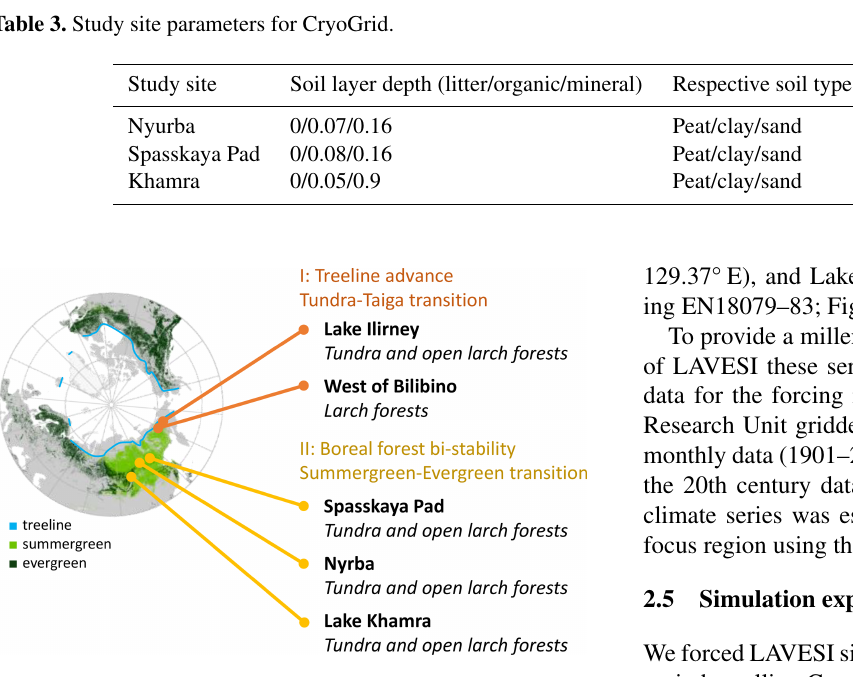
Figure 1. Scheme of focus areas covered on the Chukotka and cen- tral Yakutia 2018 expedition. Region II: boreal forest bi-stability summergreen–evergreen transition needed for the expansion of species in addition to Larix cajanderi and L. sibirica . Data in map: treeline (Walker et al., 2005); ESA CCI Land Cover forest classes (ESA,